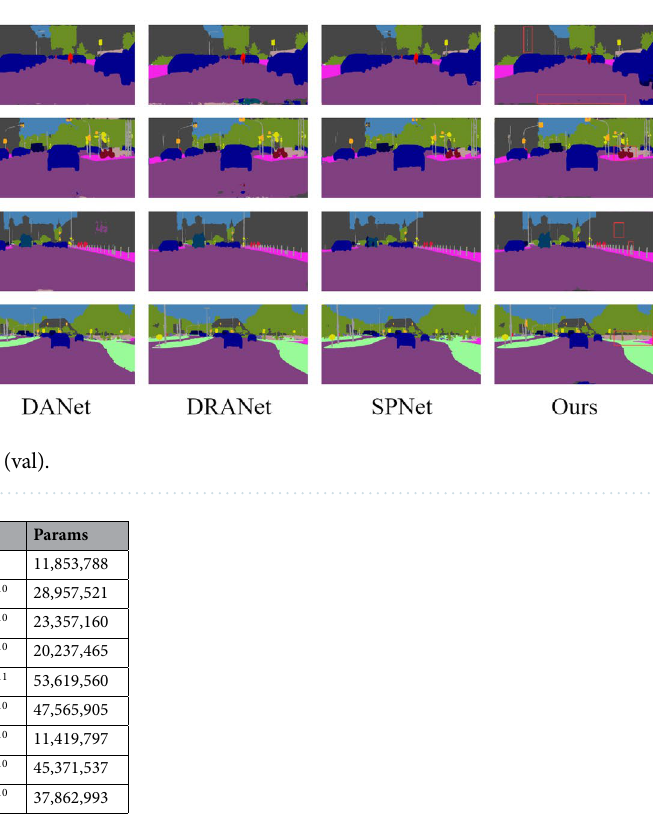
Table 5. Segmentation results on the DLRSD